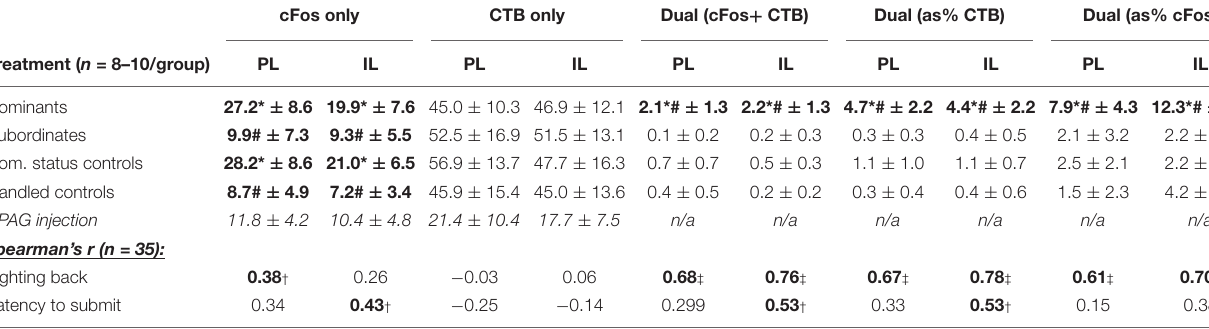
Spearman’s correlation coefficients at the bottom of the table refer to correlations between cell counts and proactive agonistic behaviors during the first of three acute defeat episodes. lvPAG denotes control injections of 4 dominants and 4 subordinates that targeted the left ventral aspect of the periaqueductal gray only and lvPAG cell counts were not included in ANOVA. Ventricle only injections yielded no CTB IR cells and are not shown. Significance is indicated as follows: bold lettering denotes statistical significance where p < 0.05. For histological comparisons: asterisks (*) denote significant difference of cell counts when compared with subordinates; pound signs (#) denote significant difference when compared with dominance status controls. For Spearman’s correlations: daggers denote significant correlations where † = p < 0.05; double daggers denote significant correlations where ‡ = p < 0.001. Sample sizes by group: Dominants, n = 9; Subordinates, n = 10; and for Dominant status controls, Handled controls, lvPAG injection, and Ventricle injection, n = 8/group.